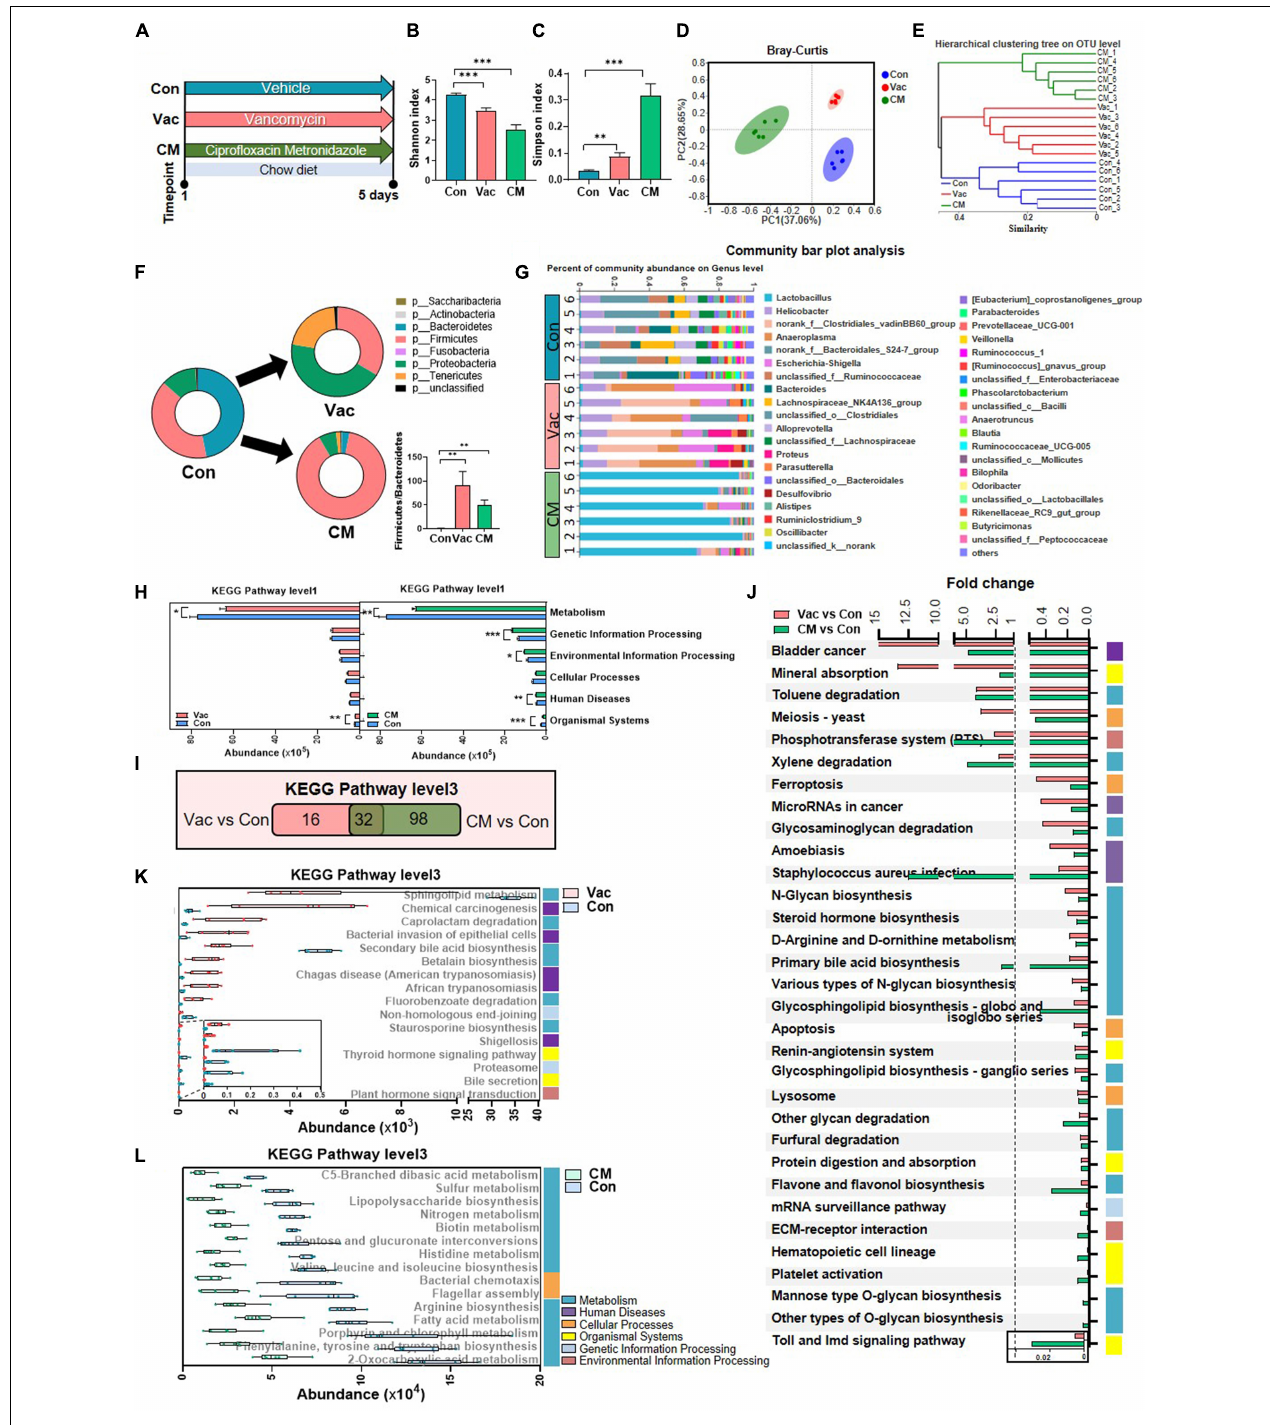
FIGURE 1 | The effects of Vac and CM intervention on regulating gut microbiota composition and function. Rats were given vancomycin (Vac) or combination of ciprofloxacin and metronidazole (CM) by oral gavage twice daily. Rats in the control group (Con) were orally administrated with water. (A) Intervention process chart. (B) Shannon index. (C) Simpson index. ** p < 0.01, *** p < 0.001 by Student’s t -test. (D) Principal co-ordinate analysis based on the Bray–Curtis distance algorithm on OTU level. (E) Hierarchical tree of sample clustering. (F) Fecal microbiota at phylum level by 16S rRNA sequencing. (G) Fecal microbiota at the genus level. (H) The function differences between Vac vs. Con and CM vs. Con on KEGG pathway level 1 predicted by PICRUSt2. * p < 0.05, ** p < 0.01, and *** p < 0.001 by the Mann–Whitney U test. (I) Venn diagram of the overlap of differential enriched pathways between Vac vs. Con and CM vs. Con by PICRUSt2 analysis on KEGG pathway level 3 ( p < 0.01 under the Mann–Whitney U test, fold change (FC) < 0.5 or > 2). (J) The 32 common pathways between Vac vs. Con and CM vs. Con. (K) The 16 unique pathways between Vac and Con groups. (L) Top 15 unique pathways between CM and Con groups. n = 6 per group.